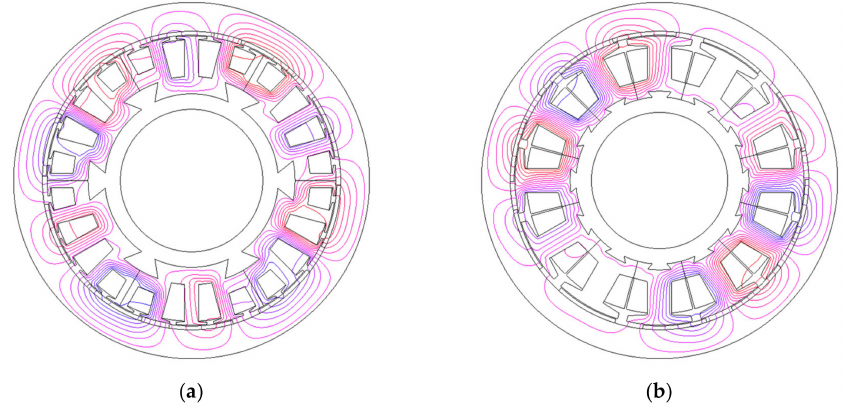
Figure 12. Armature reaction fields: ( a ) proposed machine, ( b ) conventional